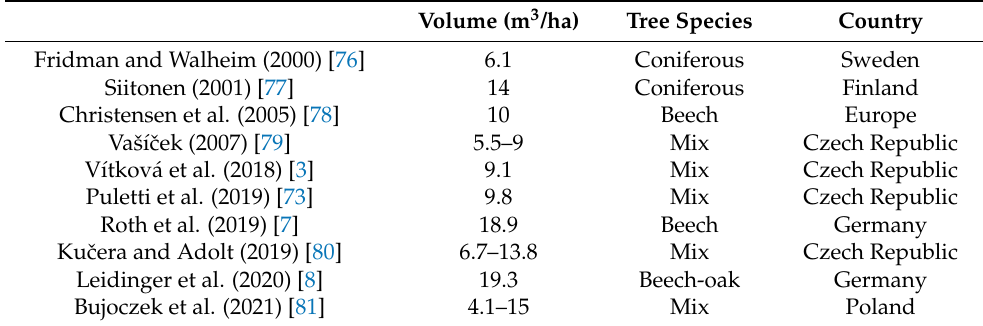
Table 1. Volume of deadwood in managed stands (m 3